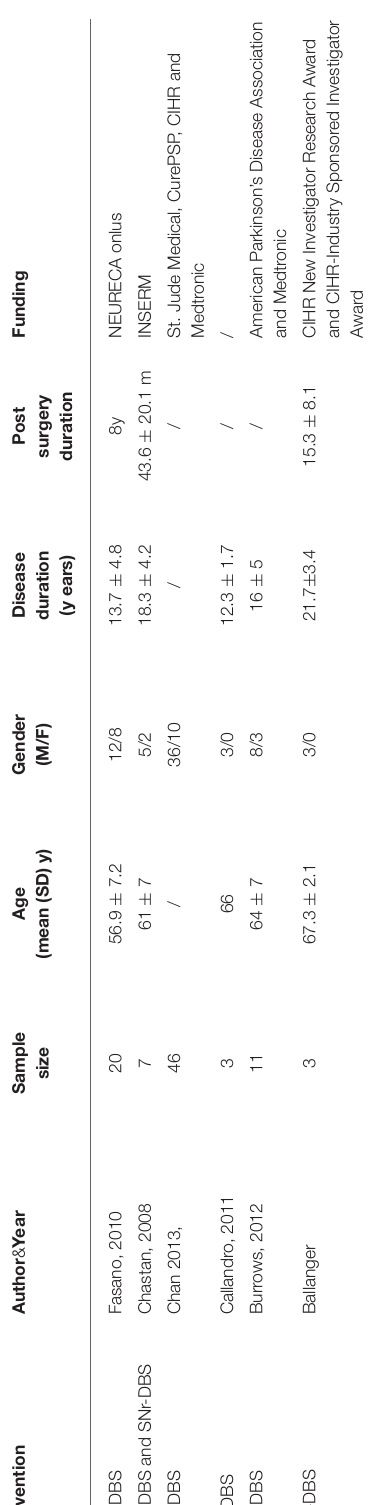
three surgical interventions is that based on the SUCRA scores that is as follows: The GPi-DBS (SUCRA = 67.75%) ranks first, followed by STN-DBS (SUCRA = 44.80%), and PPN-DBS (SUCRA = 37.40%) ranks